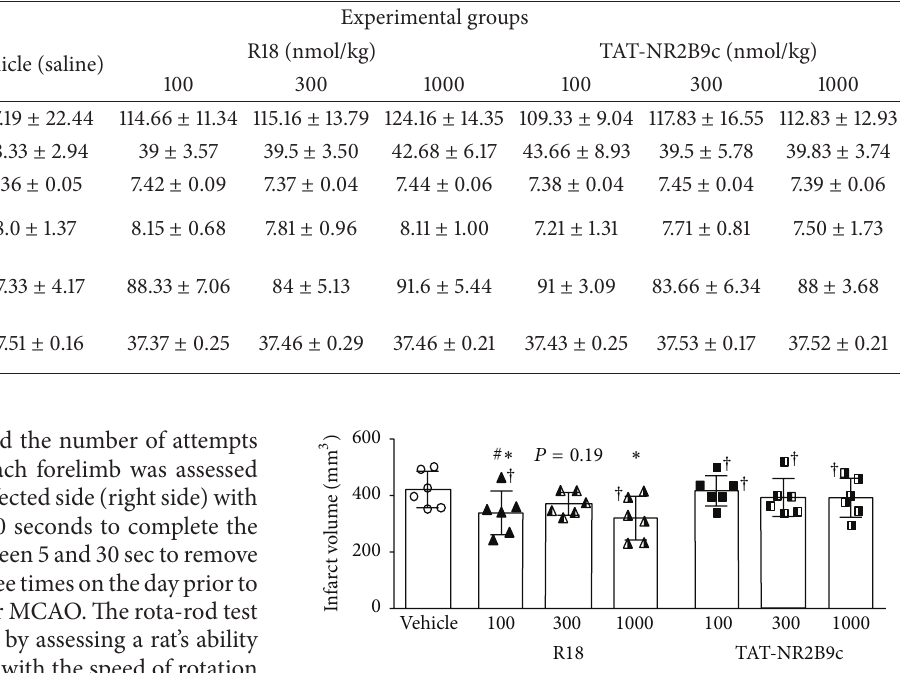
Figure 1: Infarct volume measurements 24 hours after permanent MCAO. Treatments were administered intravenously (saline vehicle or R18 and TAT-NR2B9c peptide at 100, 300, or 1000 nmol/kg; 600 𝜇 L volume over 6 min) 60 minutes after MCAO. Values are mean ± SD. ∗ 𝑃 < 0.05 when compared to the vehicle control group and # 𝑃 < 0.05 when compared to the TAT-NR2B9c 100 nmol/kg group. † denotes animals that died several hours before the 24-hour post-MCAO study end-point but were still included in the final infarct volume